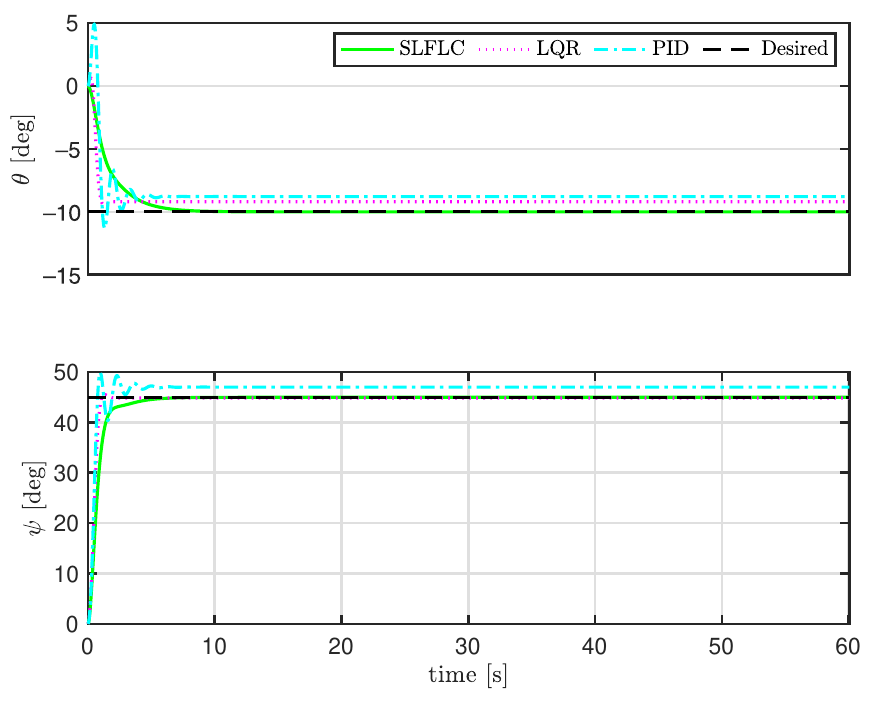
Figure 7. Trajectory tracking (Case